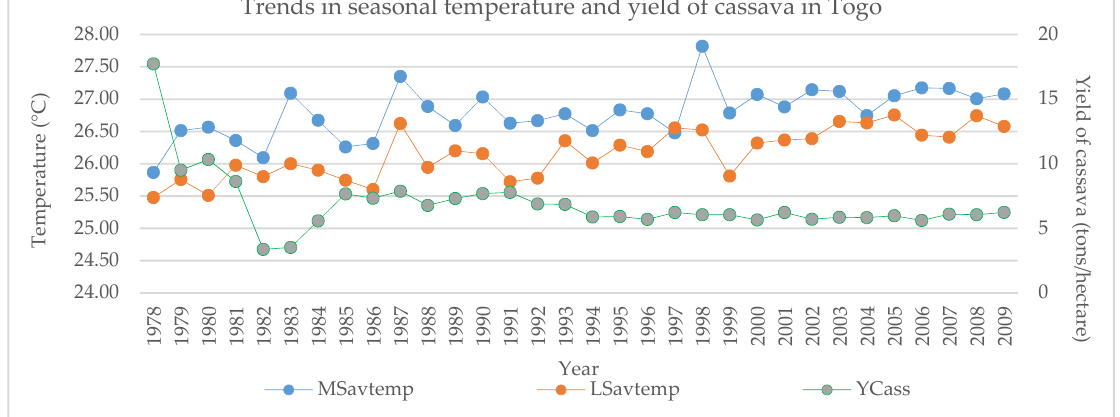
Figure 3. Rainfall and temperature trends in the ‘Cassava belt’ of Togo. Source: Author’s construct with data from the National Meteorological Service. NB: MSavprec—rainfall for the main season; LSavprec—rainfall for the lean season; MSavtemp—mean temperature for the main season; LSavtemp—mean temperature for the lean season; YCass—Yield of cassava.